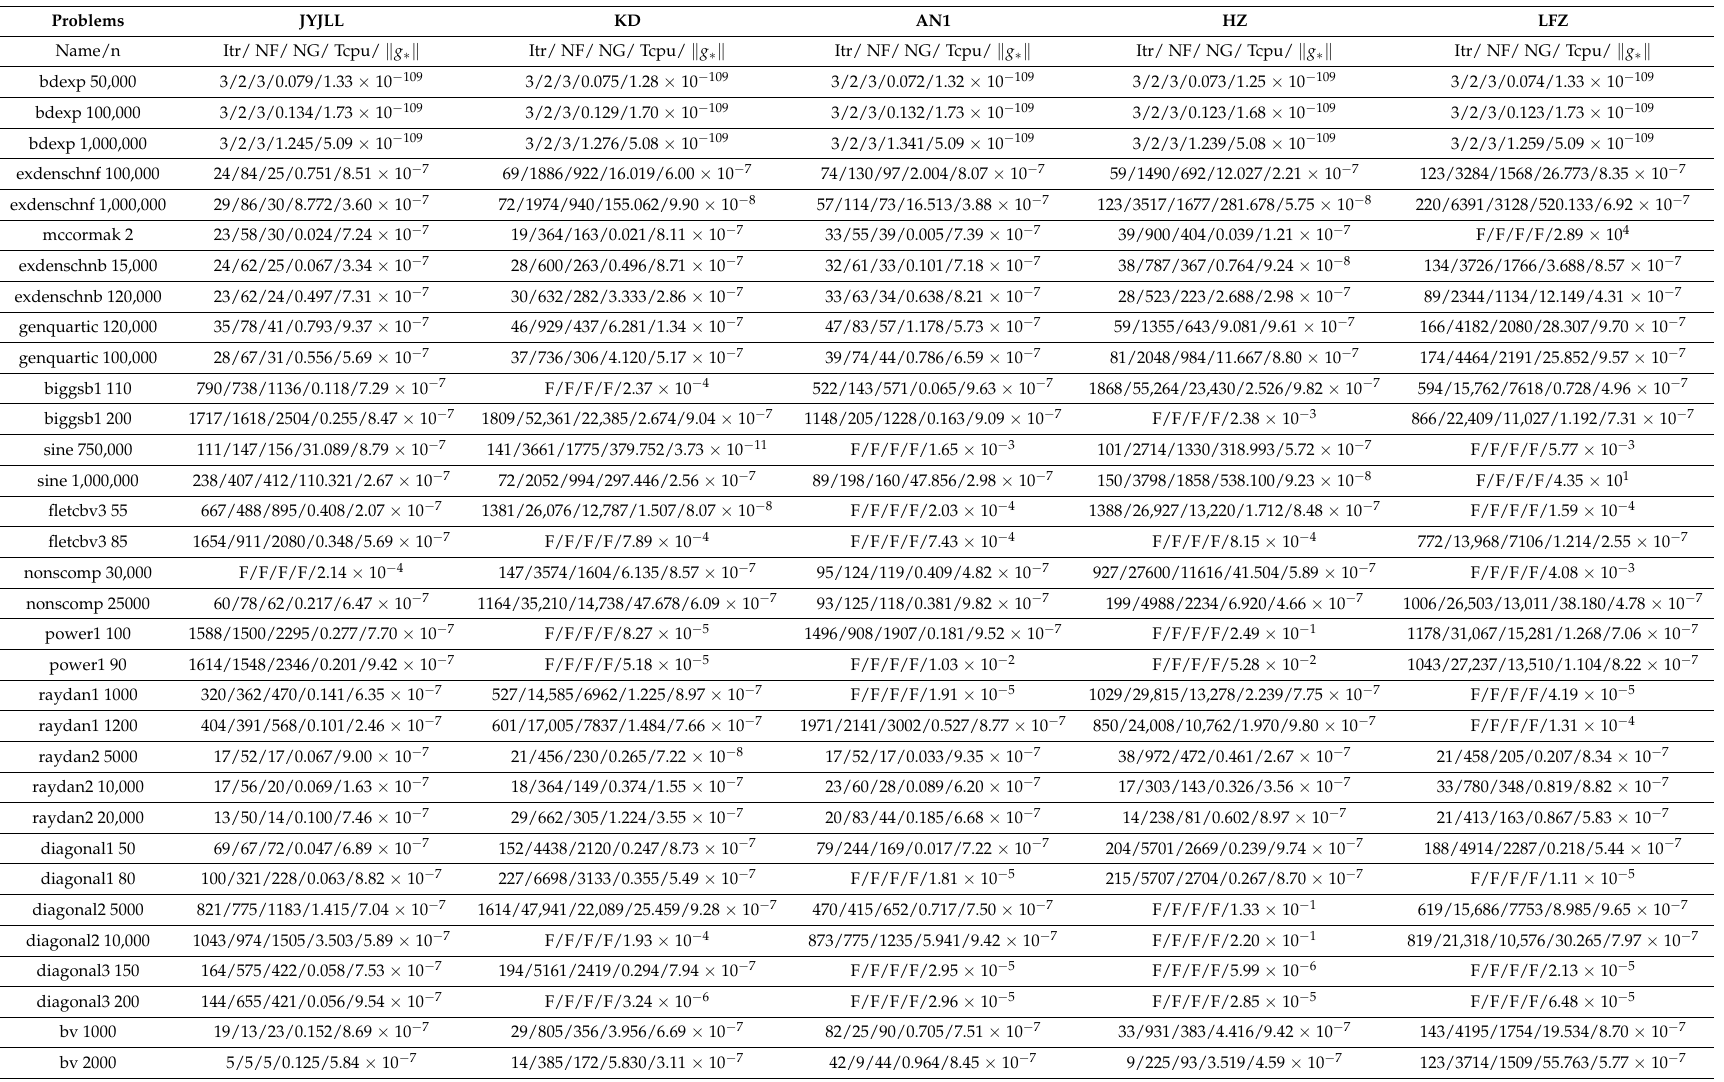
Table 2. Numerical test reports for the five tested methods